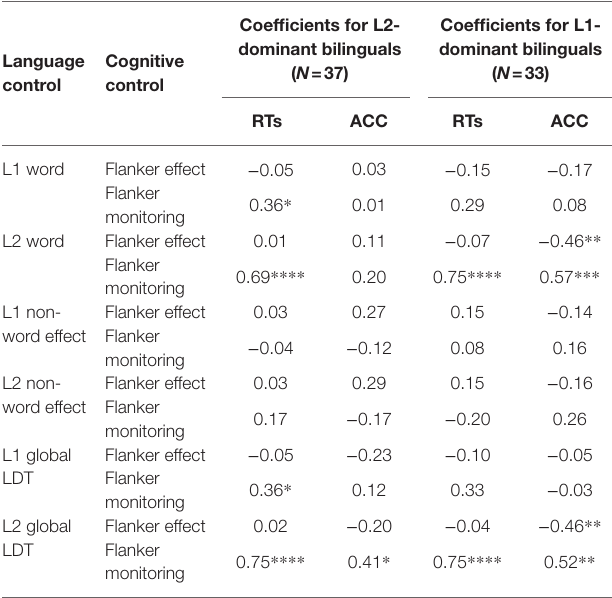
TABLE 9 | Pearson correlations, respectively, for L1- and L2-dominant bilinguals (controlling for IQ), between language control measured by the lexical decision task (LDT) and cognitive control measured by the flanker task at the dimension of response times (RTs) and accuracy rates